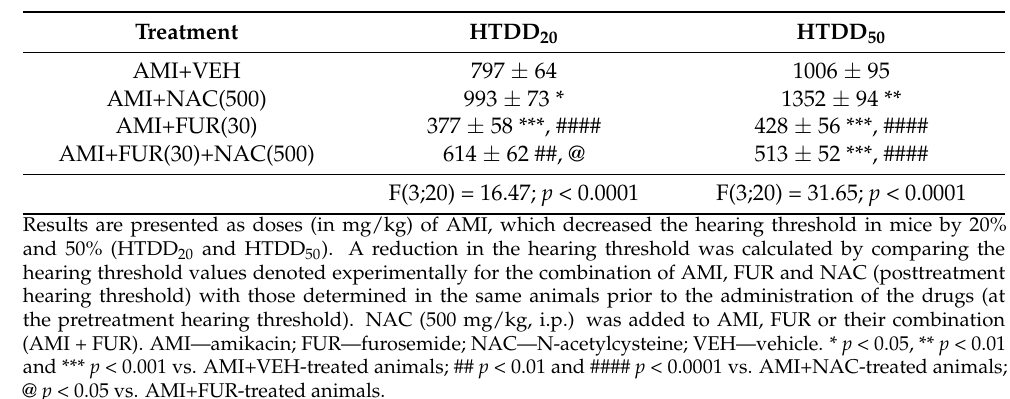
Table 1. Influence of AMI, FUR and NAC on the reduction in hearing threshold in animals receiving the drugs either alone or in